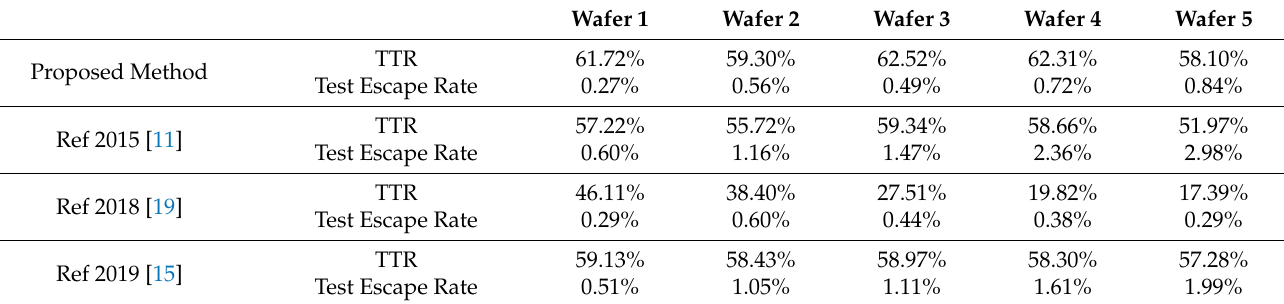
Table 3. Results when using different